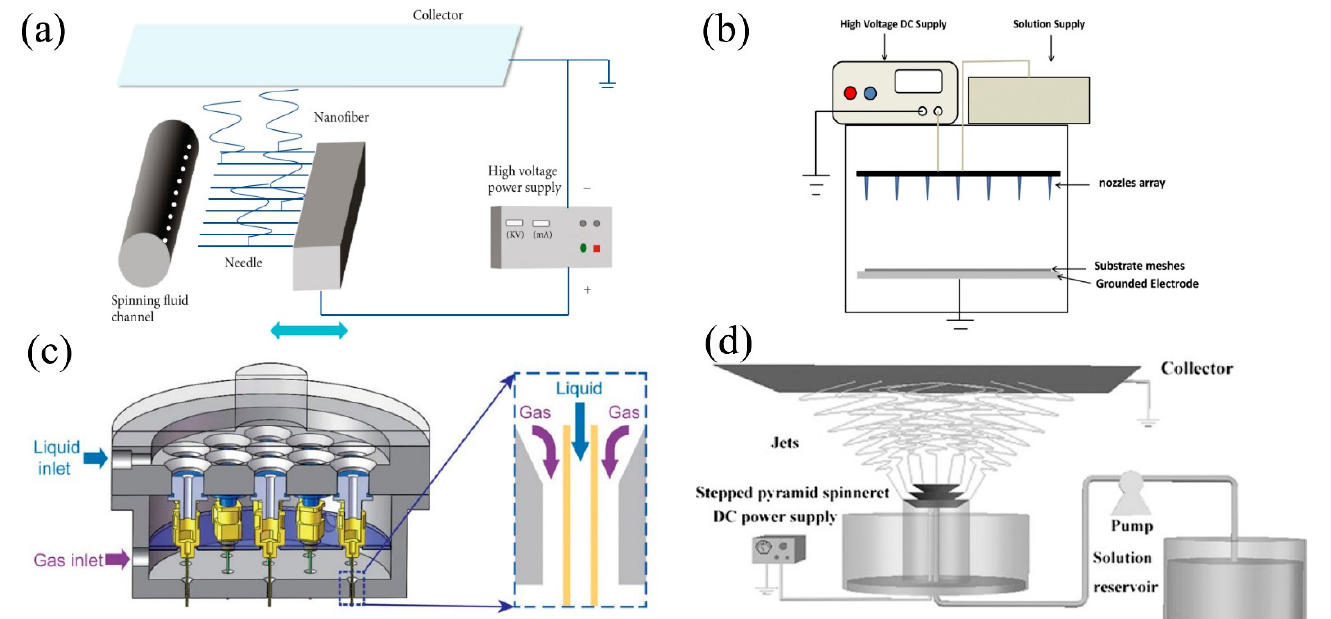
Figure 4. ( a ) Schematic diagram of the multi-needle external liquid e-spinning device. Reprinted with permission from ref. [35]. Copyright 2020 Yuan Xu et al. ( b ) Schematic diagrams of the needle-based electrospinning machine. Reprinted with permission from ref. [37]. Copyright 2020 Rongguang Zhang et al. ( c ) Structure of the sheath gas constrained multinozzle spinneret. Reprinted with permission from ref. [39]. Copyright 2019 Wiley Periodicals, Inc. ( d ) Scheme of the electrospinning apparatus using a stepped pyramid spinneret. Reprinted with permission from ref. [40]. Copyright 2017 Wiley-VCH Verlag GmbH & Co.KGaA, Weinheim.